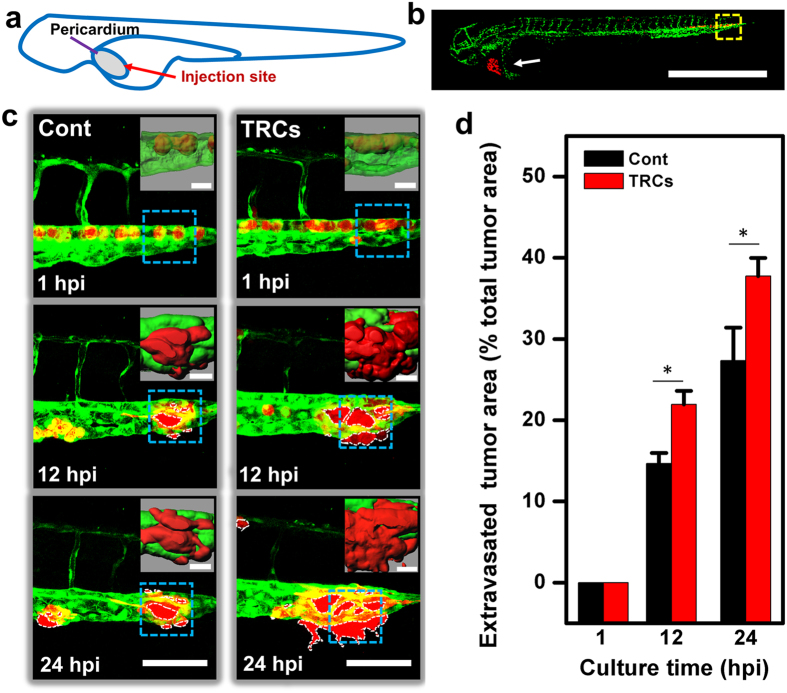
TRCs extravasate more effectively than control melanoma cells in vivo.(a) Schematic of injecting tumor cells into the pericardium of the fish. (b) A low resolution confocal image showing injected tumor cells (white arrow) being moved to the tail (yellow dashed-line box) 1 hr after injection. Scale bar, 1 mm. (c) TRCs and Cont were injected into the pericardium of 48 hpf embryos respectively. Images in each panel (246 μm × 246 μm) corresponding to the yellow dashed-line box area in (b) were acquired with high resolution confocal microscopy (63 × objective), showing vessel penetration of Cont (left panels) or TRCs (right panels) at 1 (yet to penetrate), 12 and 24 hpi respectively and summarized in (d). Acquired images were stacked in z-axis and vessel boundaries were outlined to quantify the cell areas that were out of the vessels as extravasated areas and that were inside the vessels. Dashed white lines mark the tumor extravasated areas (i.e., various sizes of micrometastases) from vessels to surrounding tissues. Insets were 3D-images reconstructed using Imaris software that correspond to respective blue dashed boxes, showing tumor cells stay inside the vessels at 1 hpi and extravasated gradually at 12 and 24 hpi. Scale bars, 100 μm; Insets scale bars, 20 μm. It is of interest to note that the extravasated cells are in general cell aggregates. (d) Quantification of extravasated tumor area relative to the total tumor area at different time points: 1, 12, and 24 hpi. Color code: Zebrafish blood vessels are green, and mouse tumor cells are red. TRCs exhibit higher penetration rates than Cont. (n >6 fish per group; ≥3 independent experiments). Mean + s.e.m.; *p < 0.05.